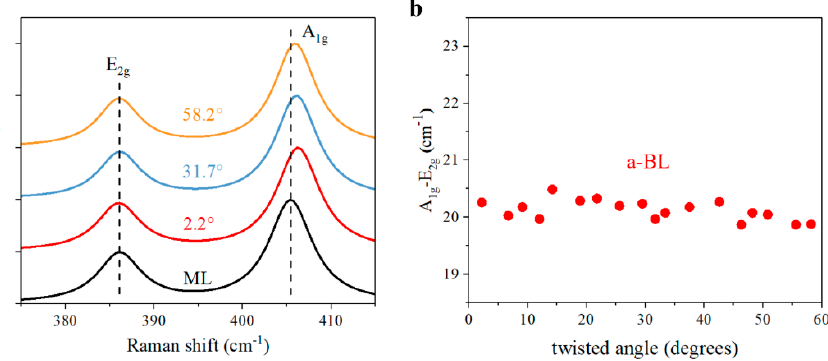
Figure 8. Raman spectra of MoS 2 bilayers with anomalous interlayer coupling. ( a ) Raman signals of A 1 g and E 2 g modes in prototypical monolayer and anomalous bilayers. ML, monolayer. ( b ) Raman interval of A 1 g and E 2 g modes. a-BL, anomalous bilayer.